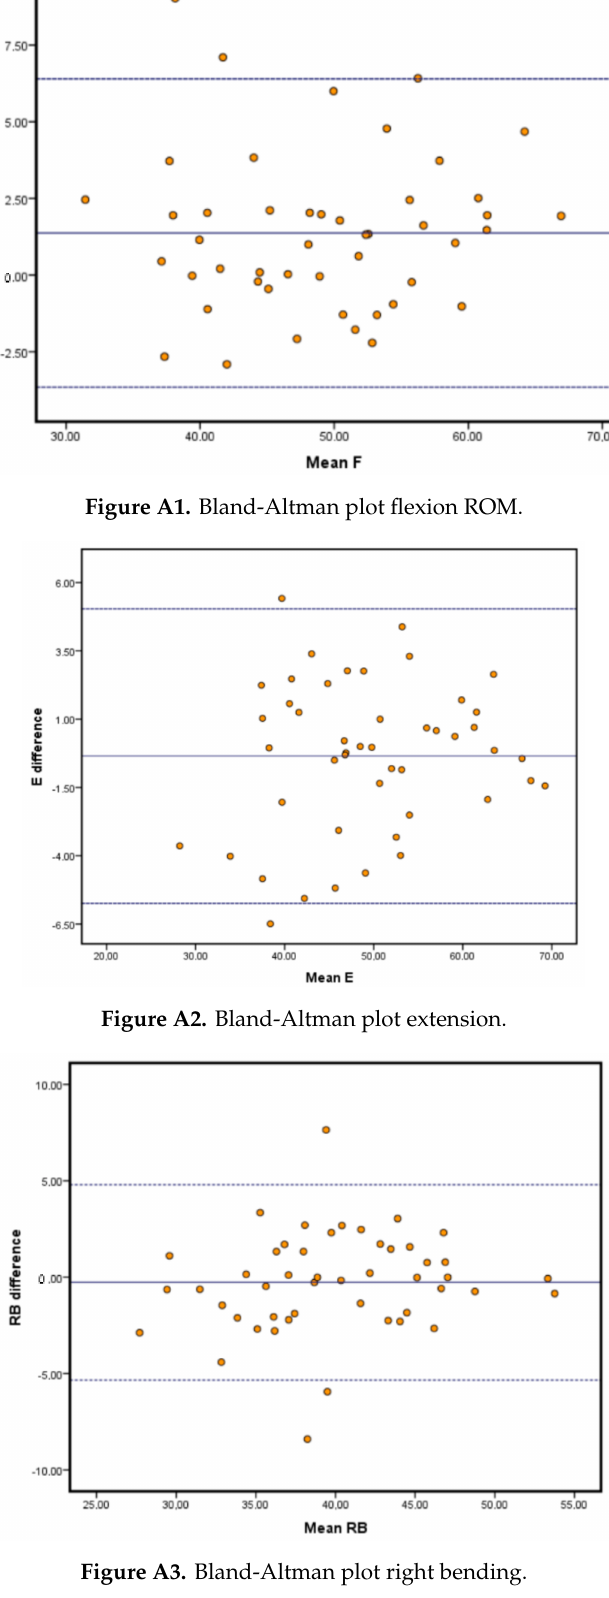
Figure A3. Bland-Altman plot right